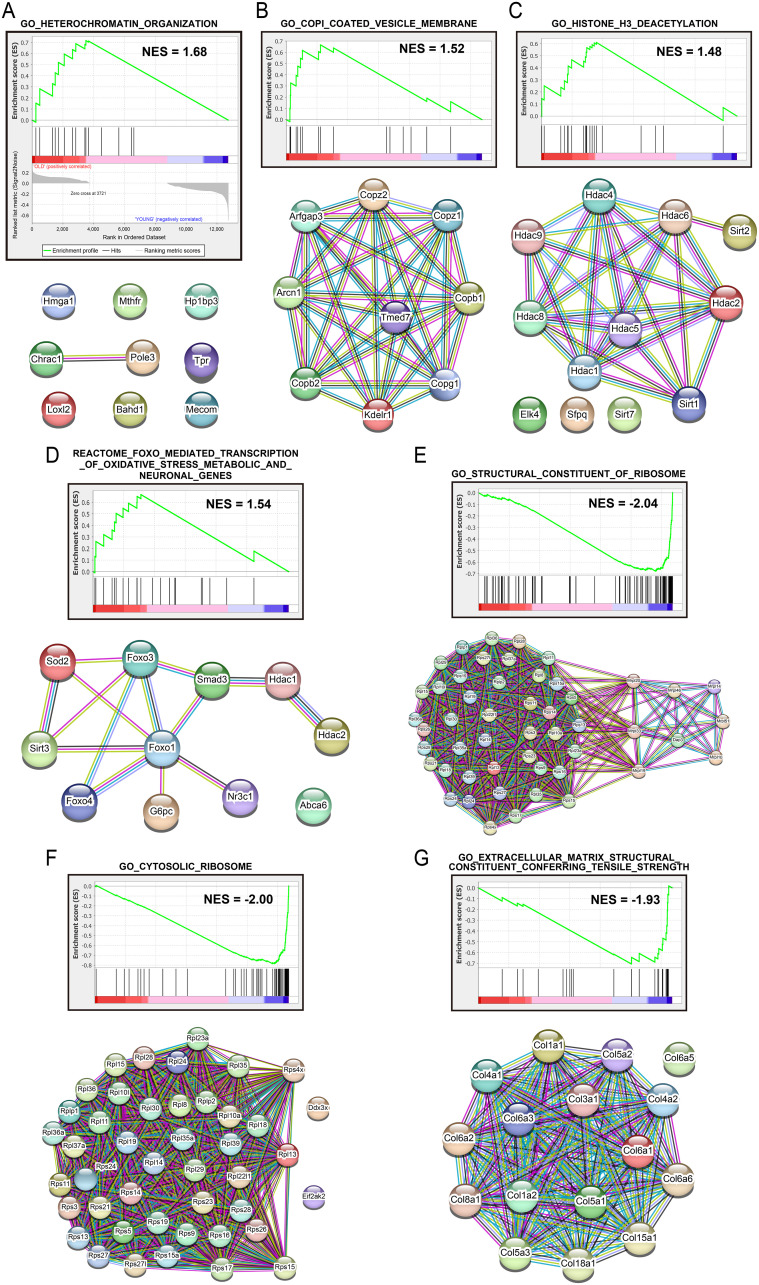
GSEA and PPI analysis between young and old ASCs.GSEA results showing the enrichment score (green line) and gene distributions (black line) among 12,729 genes rearranged according to the relative expression levels in Group 3 between young and old mice. Bars colored according to the gene distribution between the young (blue) and old (red) groups are shown. (A-C), (E-G) Results obtained using the GO public database (c5.all). (D) Results obtained using a curated public database (c2.all). All figures’ nominal p-values are lower than 0.05. (A–G) PPI among core enrichment genes of each gene set were analyzed using STRING. The confidence score cutoff for showing edges was set to ‘high’ (confidence score > 7.0). Edge colors indicated the type of evidence such as (i) co-expression (black), (ii) text-mining (yellow), (iii) biochemical/genetic data (“experiments”) (magenta), and (iv) previously curated pathway and protein-complex knowledge (“databases”) (cyan) of STRING.